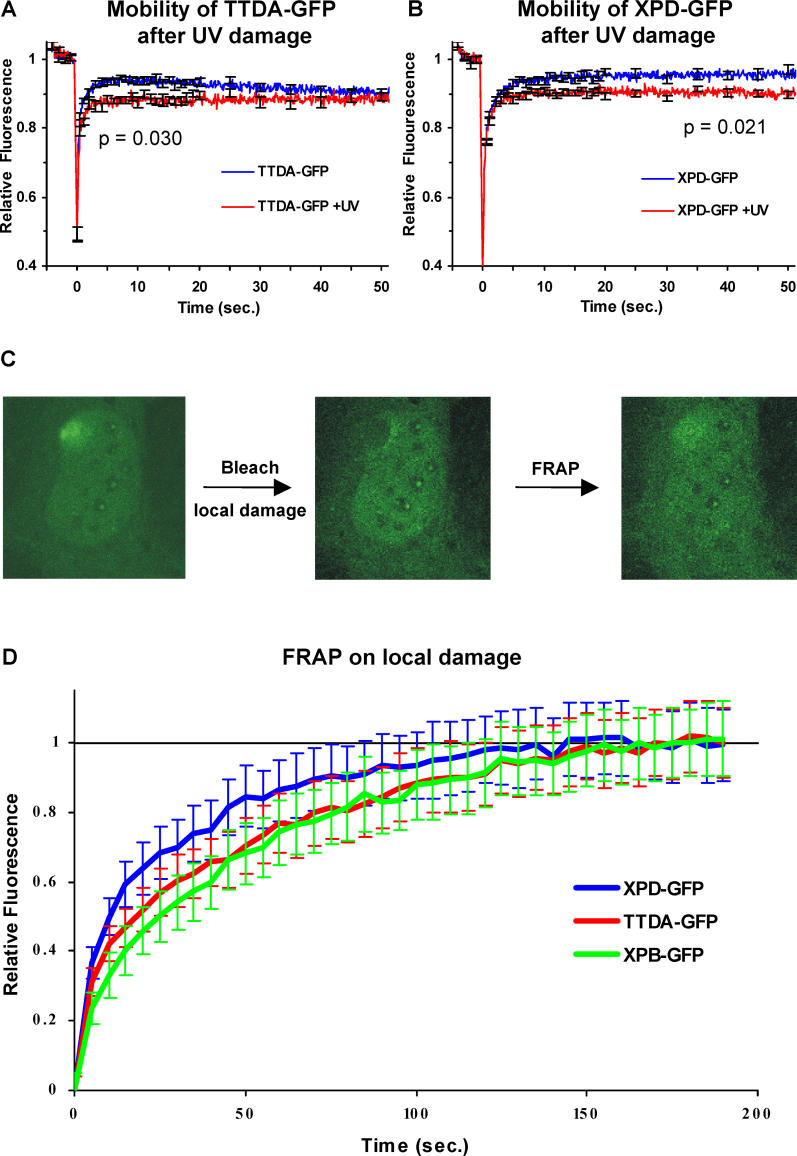
Mobility of TTDA-GFP and XPD-GFP after UV Irradiation(A) FRAP_abc of TTDA-GFP expressing cells untreated (blue line) and treated with 8J/m2 UV-C (red line). Error bars are included in the curves, and the
p-value has been calculated for the two distinct datasets.
(B) FRAP_abc of XPD-GFP-expressing cells untreated (blue line) and treated with 8J/m2 UV-C (red line). For each line at least 20 different cells were measured. Error bars are included in the curves, and the
p-value has been calculated for the two distinct datasets.
(C) Example of FRAP on local damage. A TTDA-GFP-expressing cell (left panel) containing a locally inflicted UV-damaged spot (shown by the white arrow). The locally damaged area is bleached by applying a high-pulse laser beam (middle panel), and the subsequent recovery of fluorescence is followed in time (right panel).(D) Curves of FRAP on local damage of TTDA-GFP- (red line), XPD-GFP- (blue line), and XPB-GFP-(green line) expressing cells. FLD, fluorescence measured on local damage; FNLD, fluorescence measured on untreated areas. Error bars are included in the curves.